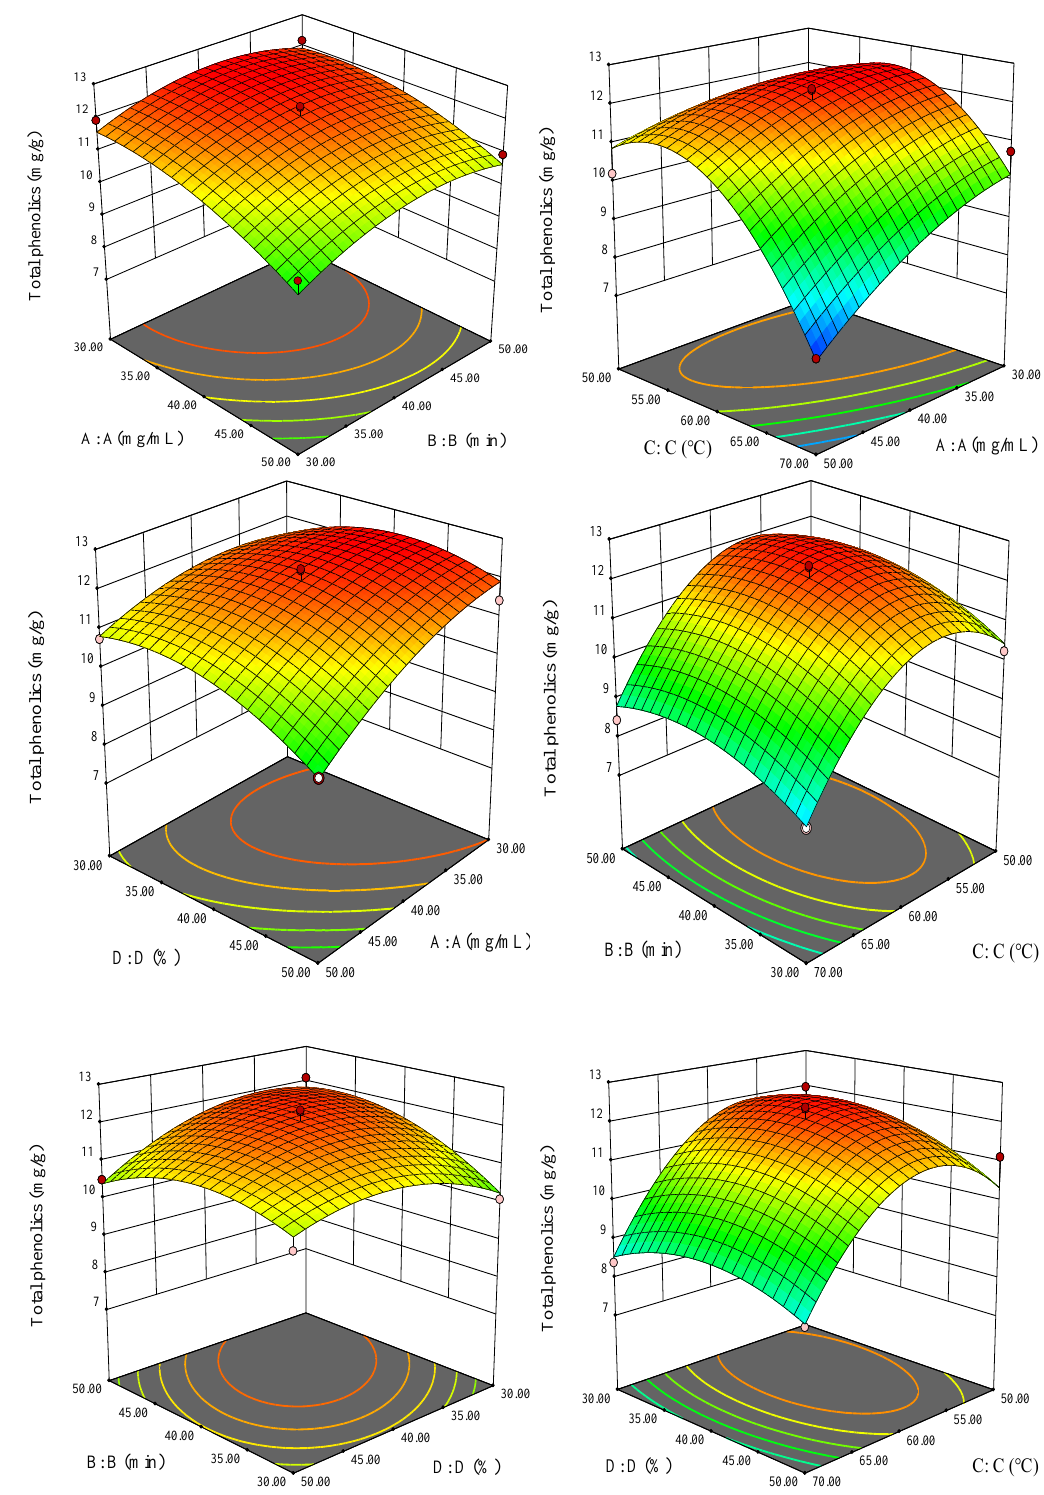
Figure 4. Response surface of the effects of the interaction of various factors on the extraction yield of S. baumii